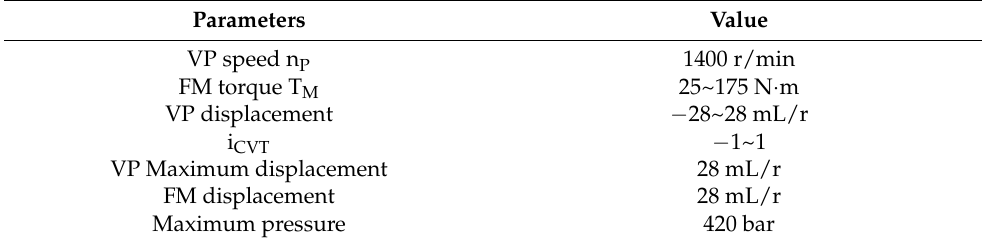
Table 2. The parameters of hydrostatic